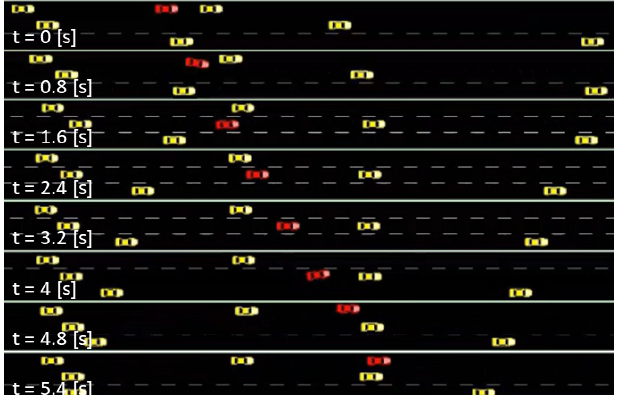
Figure 11. Sequence of extracted frames from an exemplary scenario. The ego vehicle (in red) changes lane to the right so to overtake the front vehicle and gain speed. The time initiation is appropriate to avoid a collision with rear